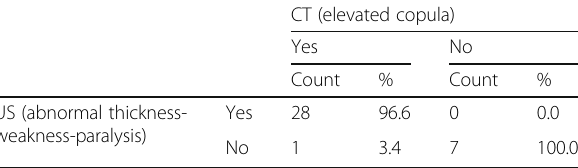
Table 2 Demonstrating the number of patients — out of total Table 4 Demonstrating the number of patients — out of total patients (36) — with hemidiaphragmatic defects/hernias as patients (36) — with hemidiaphragmatic weakness/paralysis as detected by TAUS in comparison to CT detected by TAUS relevant to an elevated diaphragmatic copula CT (defects (hernia))